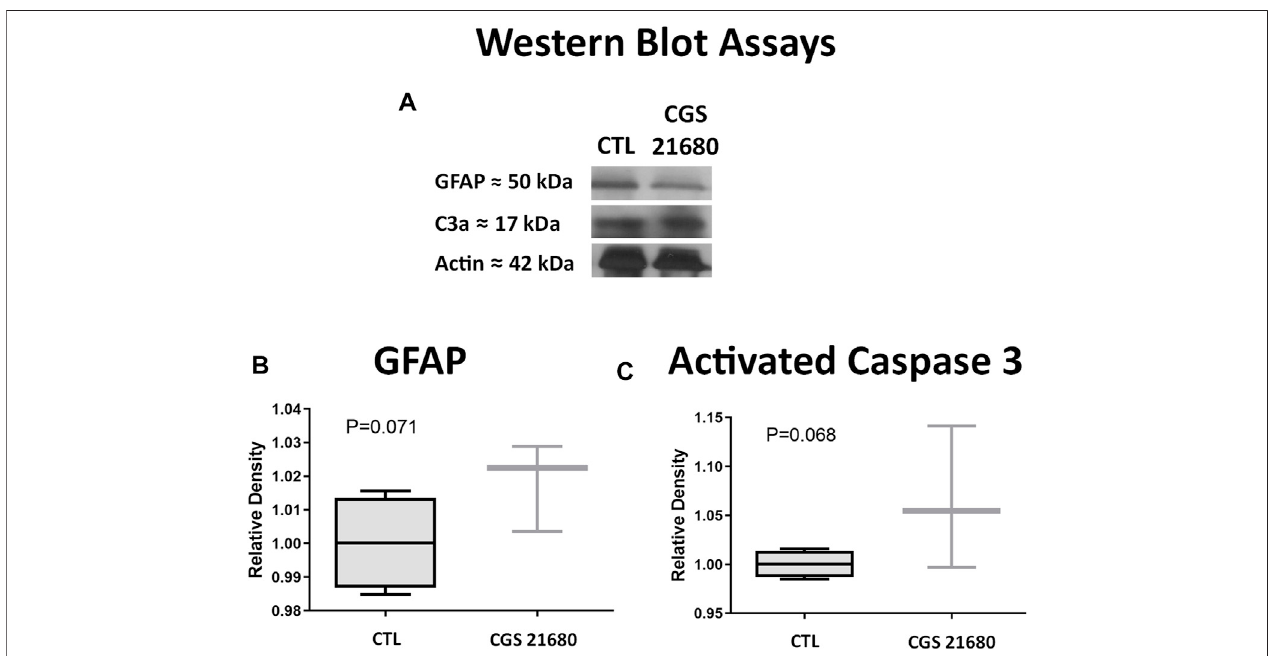
FIGURE 2 | (A) Western blots of retinas from CGS21680-treated and CTL eyes and their quanti fi cations. From top to bottom, bands correspond to GFAP, activated Caspase-3, and actin. (B) Quanti fi cation of GFAP by WB. (C) Quanti fi cation of activated caspase-3 by WB. Relative densities were normalized against CTL β -